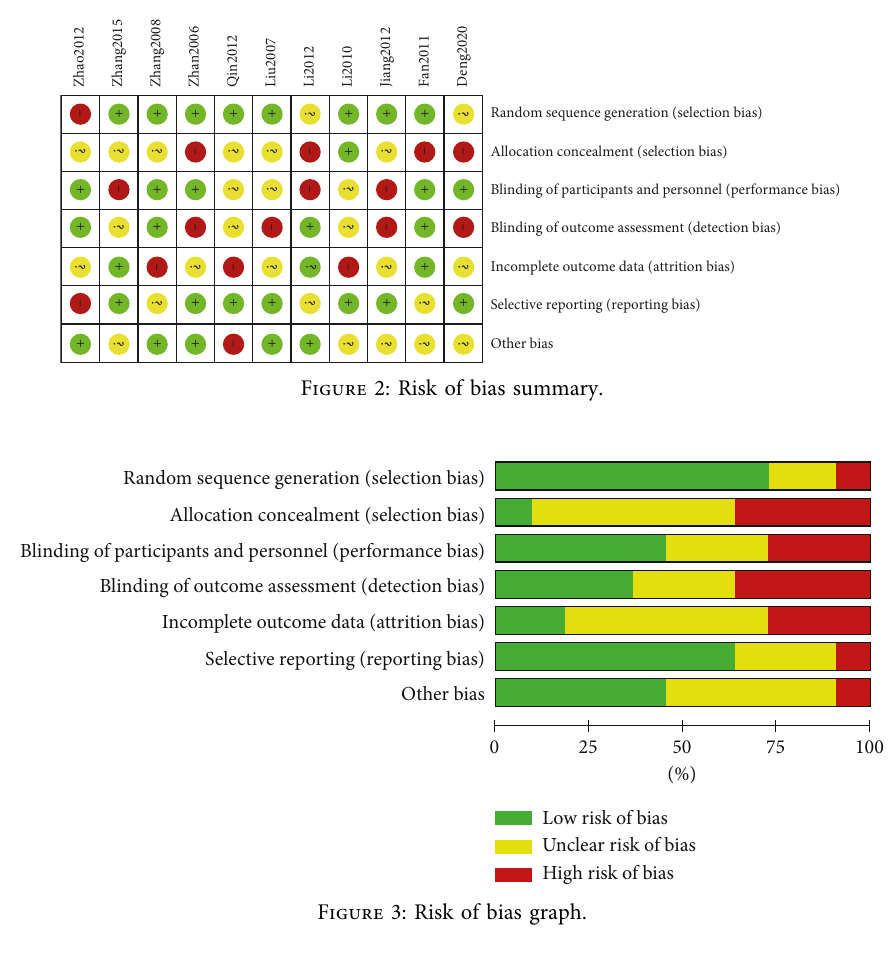
Figure 1: Literature selection process.